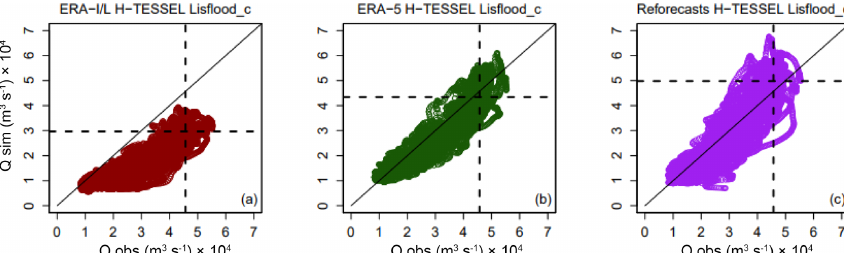
Figure 10. Scatterplots of observed against simulated river flow at the Tamshiyacu gauging site, Peru (4). For (a) ERA-Interim Land, (b) ERA-5, and (c) the European Centre for Medium-Range Weather Forecasts (ECMWF), 20-year reforecasts forced through the calibrated Lisflood routing model. Dashed black lines indicate the observed and simulated 90th percentile of river flow. For the period